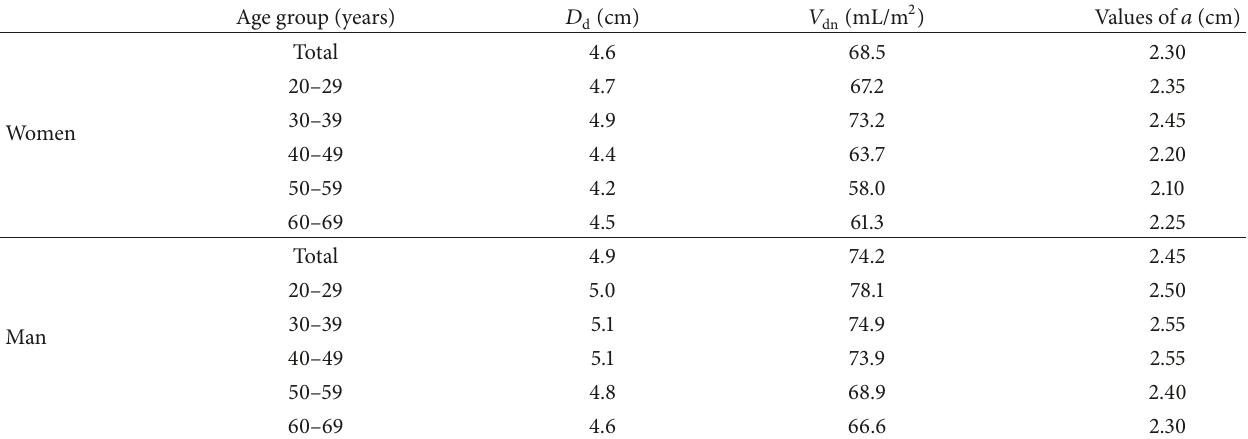
Table 1: Average of the reference measures for the LV of women and men and the calculated value 𝑎 . Age group (years) 𝐷 d (cm) 𝑉 dn (mL/m 2 ) Values of 𝑎